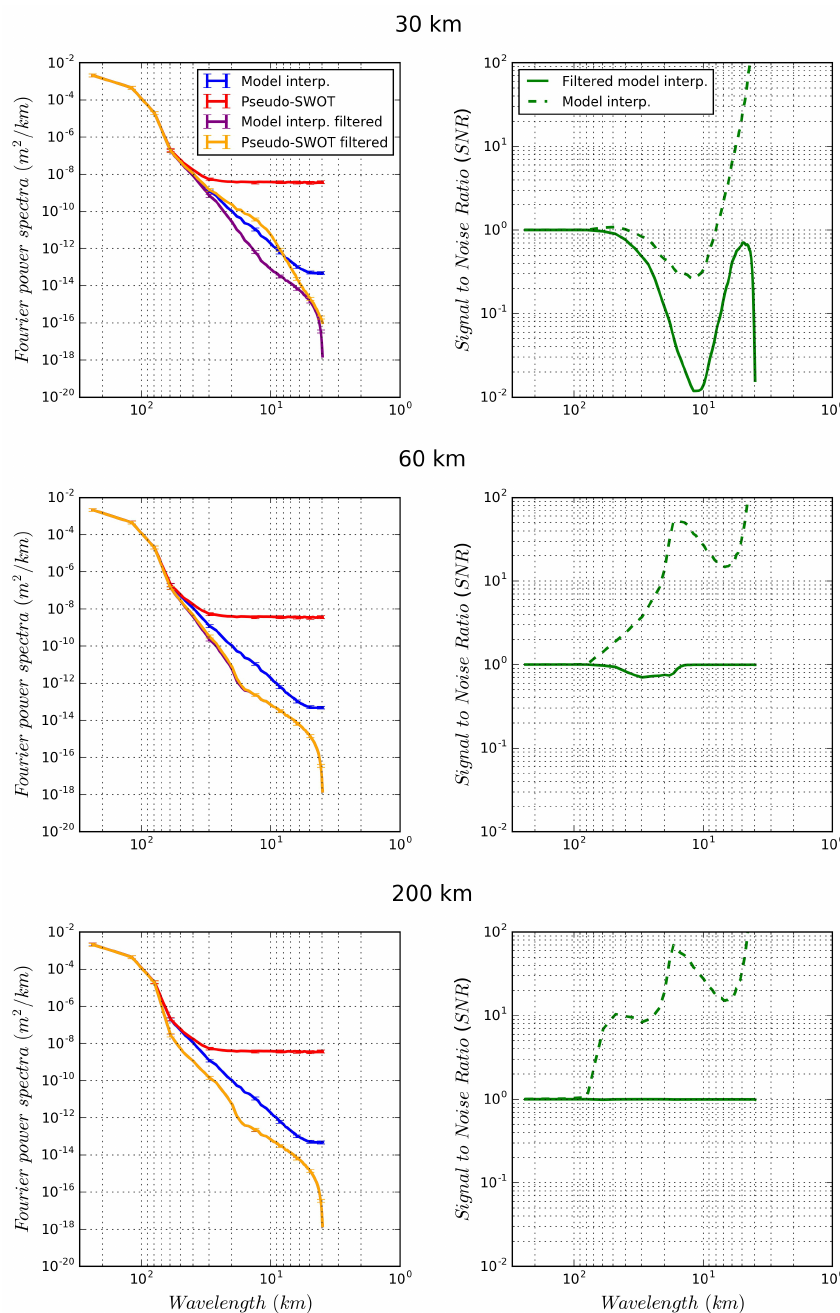
Figure 14. Box 2 region (pass 168) mean of cycles 1 to 122. ( Left ) Spectra of SSH model (blue) and SSH obs (red) before filtering and after applying the different cut-off wavelengths shown in the different rows (30, 60 and 200 km) in purple and orange, respectively. Error bars denote 95% confidence intervals. ( Right ) SNR of SSH model and SSH obs , both filtered (solid line) and of SSH model non-filtered and filtered SSH obs (dashed